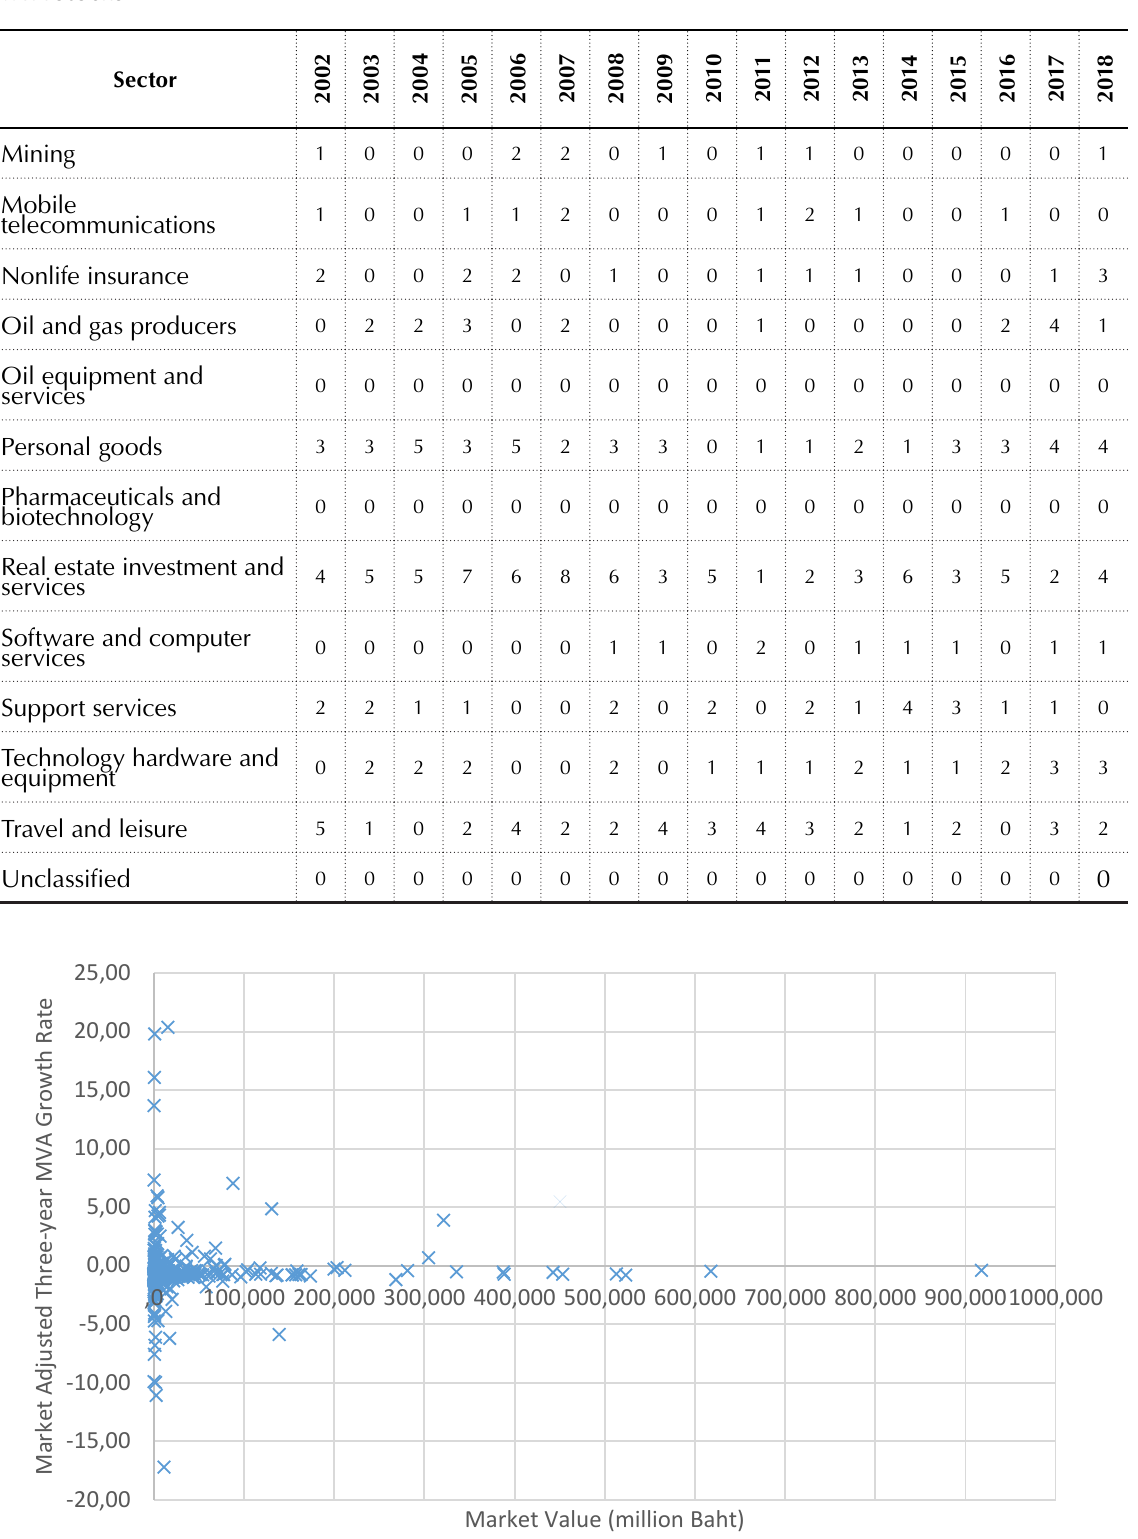
Figure 3. The scatter plot of 2018 three-year growth rate of market adjusted change of MVA and market